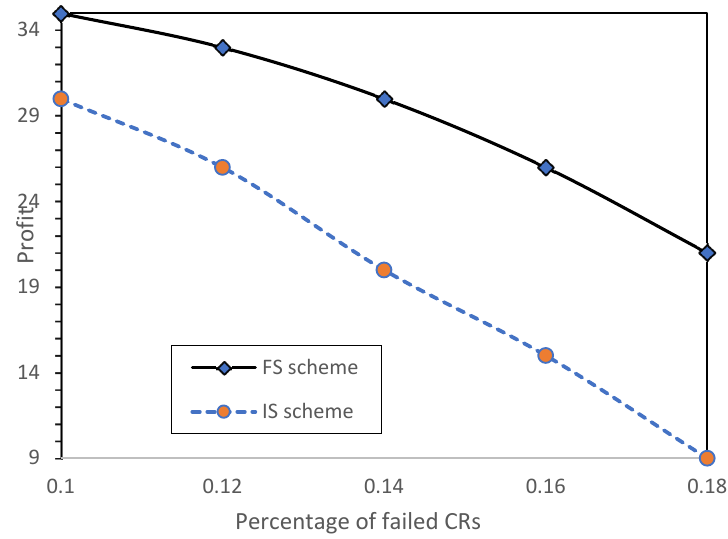
Figure 1. Profit under different percentage of failed CRs.